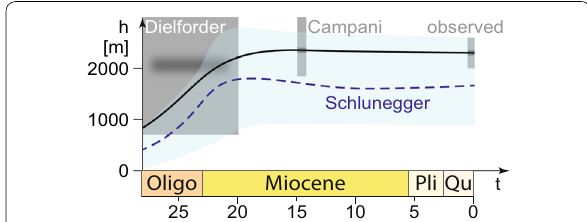
Fig. 3 Estimates of the Alpine elevation since Oligocene. Black line refers to the basis used for this study, with the Alps having a more or less steady elevation since Miocene. Mean hypsometric elevations from Campani et al. (2012), mean maximum elevation for Dielforder (2017) and paleo-altimetry estimate of Schlunegger and Kissling (2015). All estimates have large uncertainties but indicate